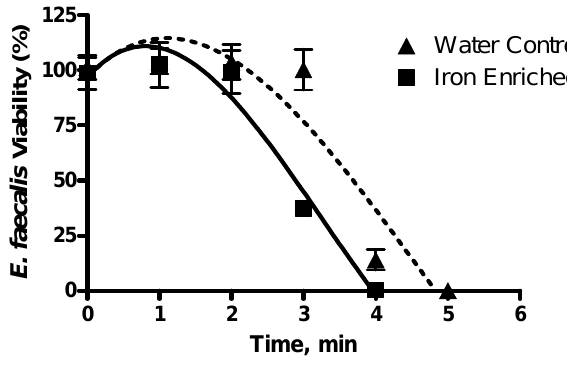
Figure 4: Effect of iron ions on microwave disinfection of E. faecalis. Illustrates the effect that iron ions (solid line) have on the deactivation of E. faecalis (n = 10) during microwave heating compared to a distilled water control (dotted line). Iron ions had a trivial effect on microwave disinfection of E. faecalis.